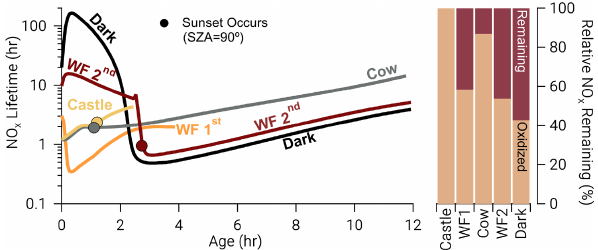
Figure 11. Time series: NO x lifetime in hours on a log scale for all model runs where closed circles indicate the time of sunset (solar zenith angle = 90 ◦ ). Bars: the relative NO x remaining calculated as the fraction of NO x remaining at the end of our model divided by the amount of NO x that was reacted, excluding dilution. After the depletion of NO, NO x chemistry changes dramatically in the WF2 and Dark model runs, reducing NO x lifetime rapidly. A significant amount of NO x remains in the WF2 and Dark model runs at sunrise, providing potential for significant morning chemistry to